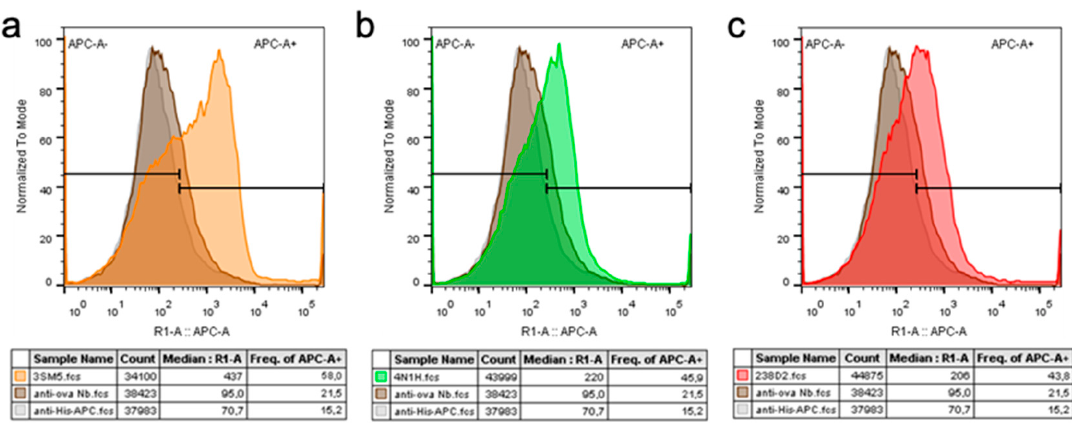
Figure A2. 3SM5 and 4N1H bind CXCR4 and trigger the same intracellular signaling as 238D2. FACS binding experiments. HEK293FT cells transiently expressing the hCXCR4 were incubated with the tested Nbs ( a . 3SM5 in orange, b . 4N1H in green, and c . 238D2 in red) for 1 h. An Nb directed against ovalbumin was used as control (shown in brown in a, b, and c). The Nbs were revealed using an APC-conjugated anti-His antibody. The signal of the anti-His-APC antibody alone is shown in gray ( a – c ).